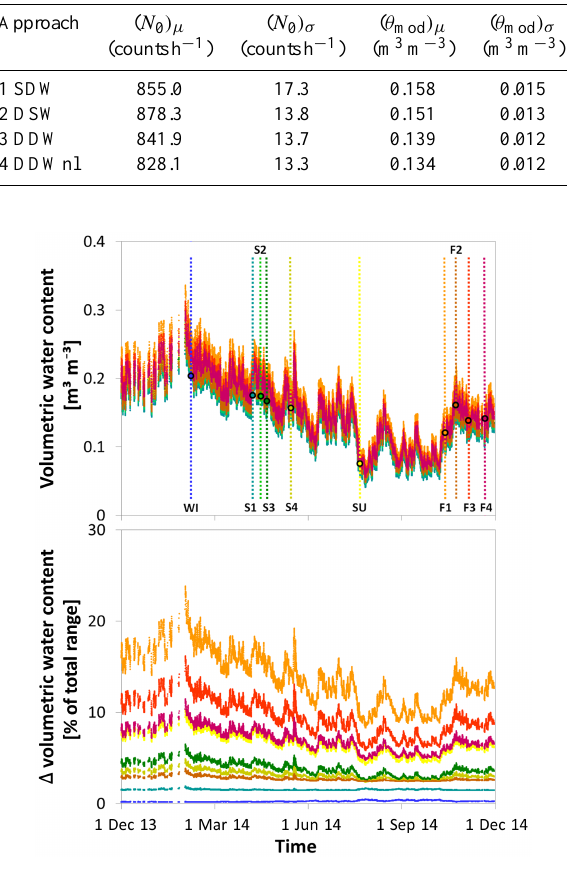
Figure 4. Upper panel: volumetric water content derived from CRS data for each of the 10 calibration dates separately (vertical lines indicate calibration dates, colors correspond to time series colors). Filled circles represent the weighted volumetric water content at the time of calibration (according to DDW). Lower panel: differences in water content between calibration S1 and all other calibrations expressed as a percentage of the total possible range of average soil water content – ranging from 0.04 to 0.34m 3 m − 3 at our field site (color coding corresponds to calibration dates in the upper panel).